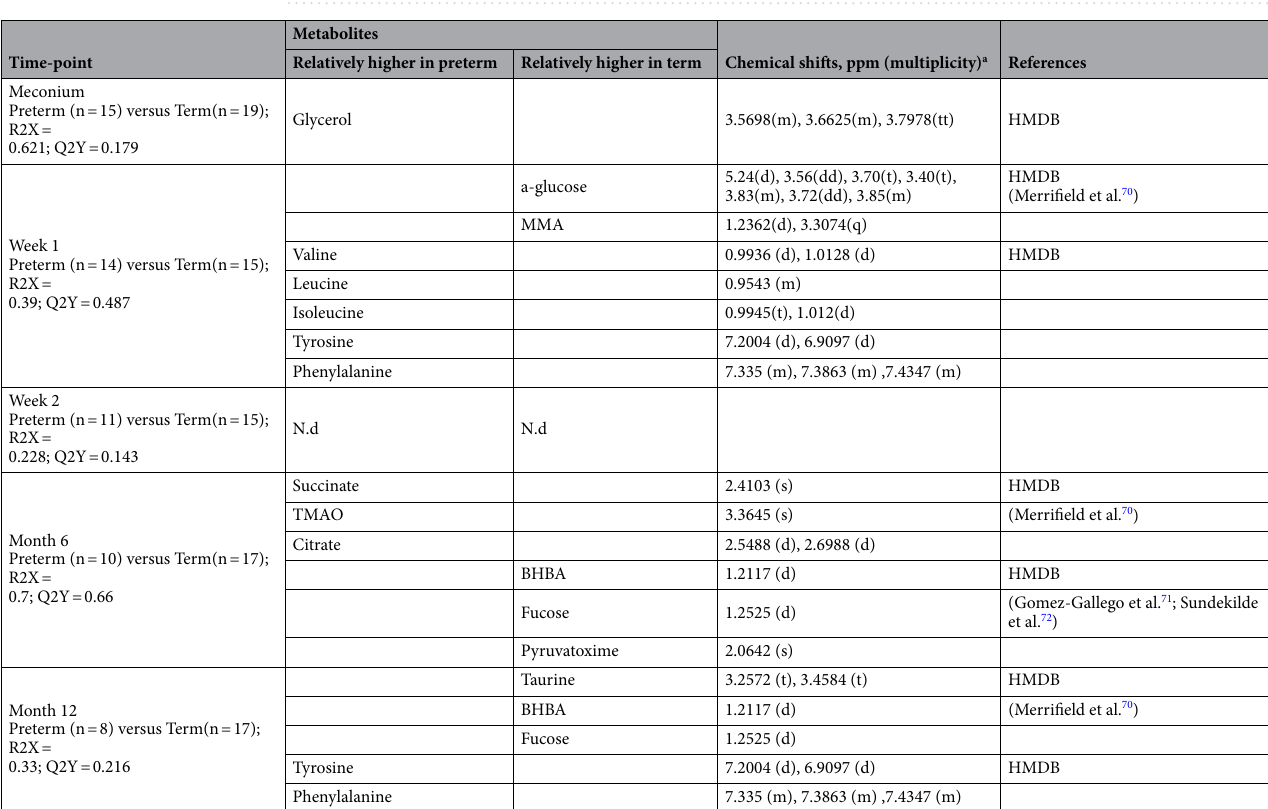
Table 3. List of 1H NMR-derived metabolites that differ significantly between preterm and term infants at different time-points. N.d = not detected. BHBA = β-hydroxybutyric acid. HMDB = Human